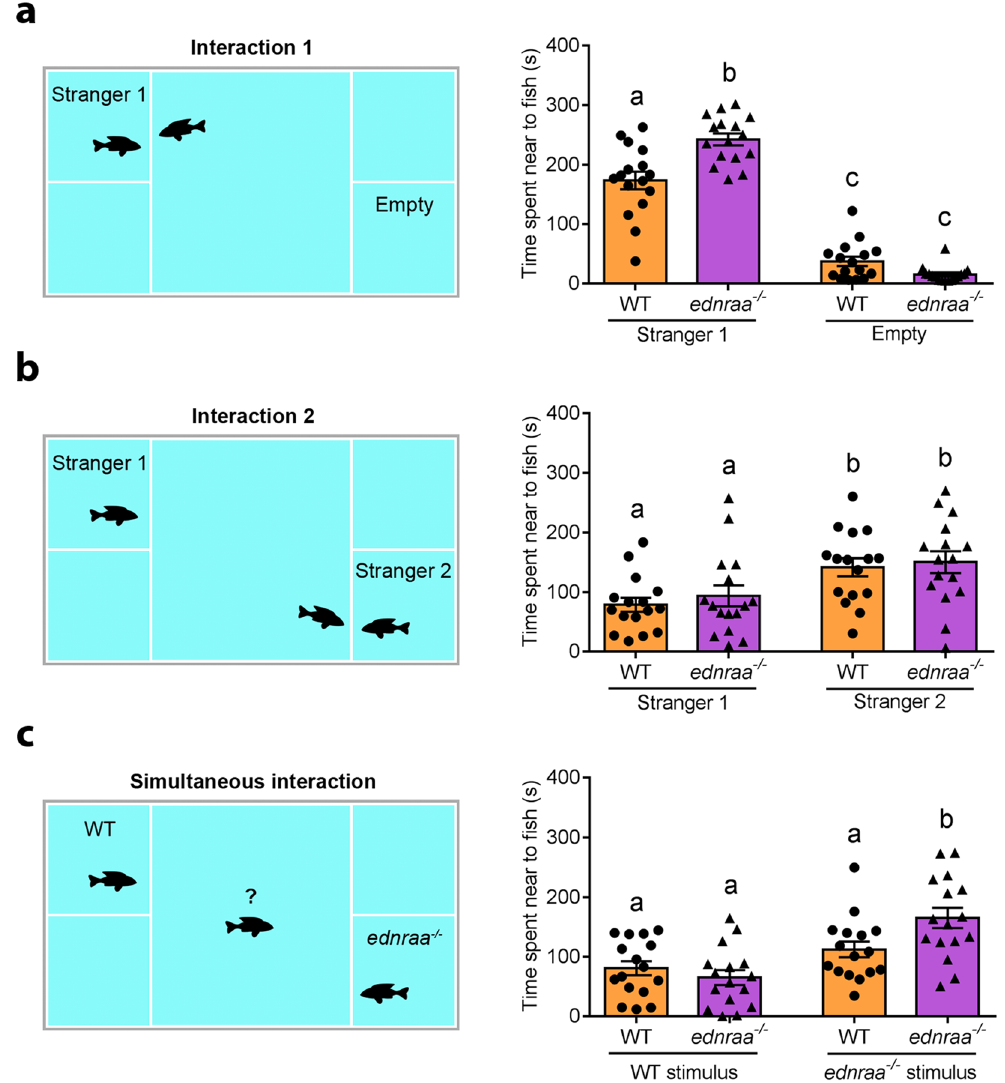
Figure 3. Social interaction and discrimination in the social preference test. ( a) Social preference. WT and ednraa − / − spend more time interacting with stranger 1 than in the empty area and ednraa − / − spend more time interacting with the stimulus fish than WT. (b) Social novelty. Both genotypes switch preference to interact with a second WT stimulus. (c) Social discrimination. When both ednraa − / − and WT are used as a stimulus, ednraa − / − prefer to interact with ednraa − / − whereas WT displays no preference. Each dot represents one fish. Letters not shared in common between or amongst groups indicate significant differences from Tukey’s (significant interaction) or Sidak’s (non-significant interaction) post hoc comparison after two-way ANOVA, p <